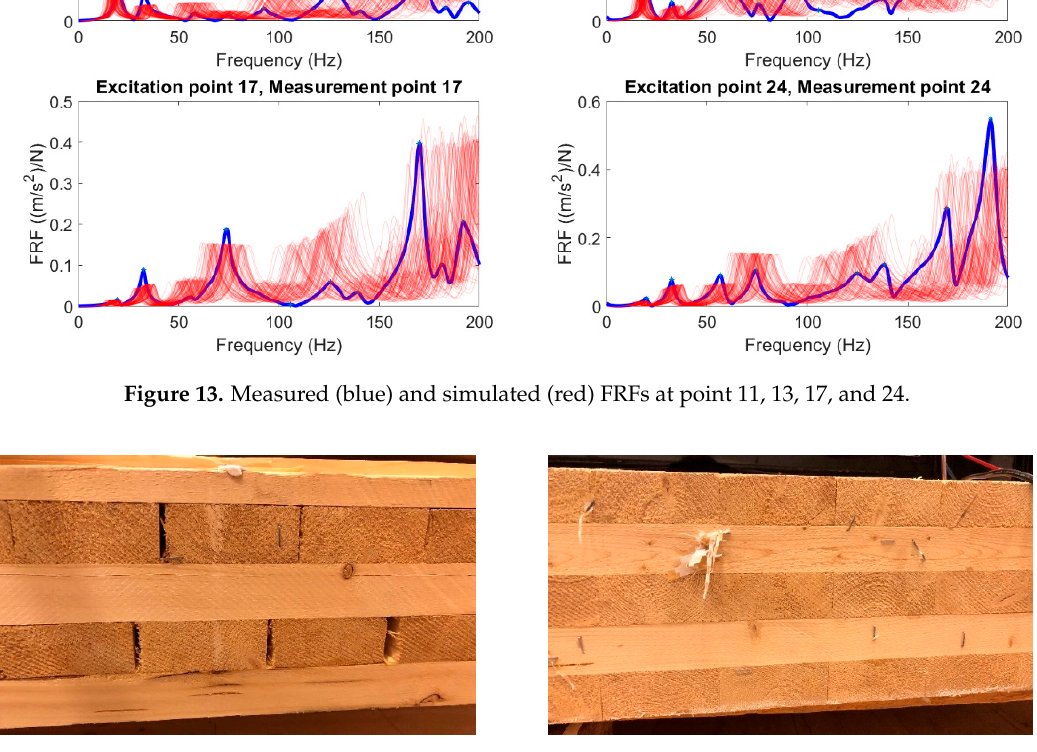
Figure 14. ( a ) Air gaps in the laminate layers of CLT. ( b ) No edge-bonding of CLT.